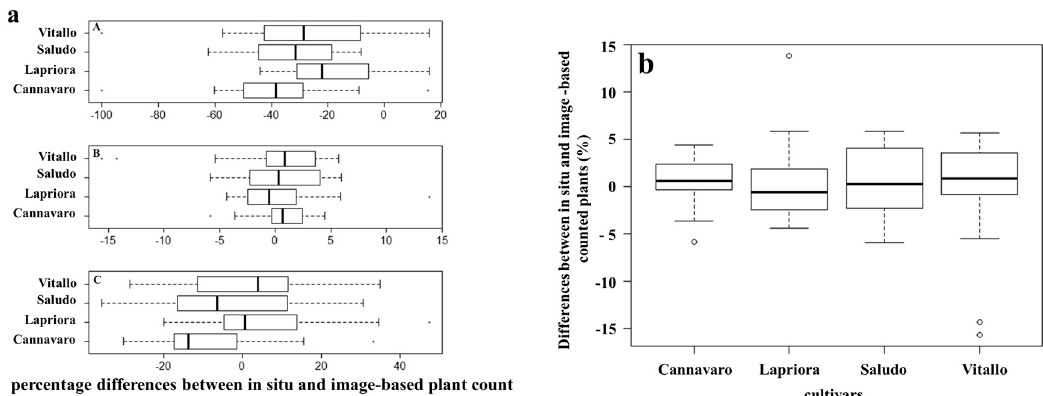
Figure 10. ( a ) Box plots illustrating the percentage differences between in situ and image-based counted plant numbers for all plots, depending on the command area opening bwareaopen (BW, p ), which allows plants to be counted in a standardized way. A has an open area of p = 3; B shows the range for p = 5 and C for p = 10. The open area is defined through the pixel area entering a limit for counted or not counted combined components being below the limit. The percentage difference is calculated as difference (%) = (digitally measured plant number—actually counted plant number)/actually counted plant number x 100. The bold line inside the box shows the median, with the upper and lower lines of the box plot representing the 75th and 25th percentiles. The circles outside the boxes are outliers; ( b ) Box plots representing the distribution of the percentage differences between the actually and digitally counted plants number from all plots. The bold line inside the box shows the median, with the upper and lower lines of the box plot representing the 75th and 25th percentiles. The circles outside the boxes represent outliers.